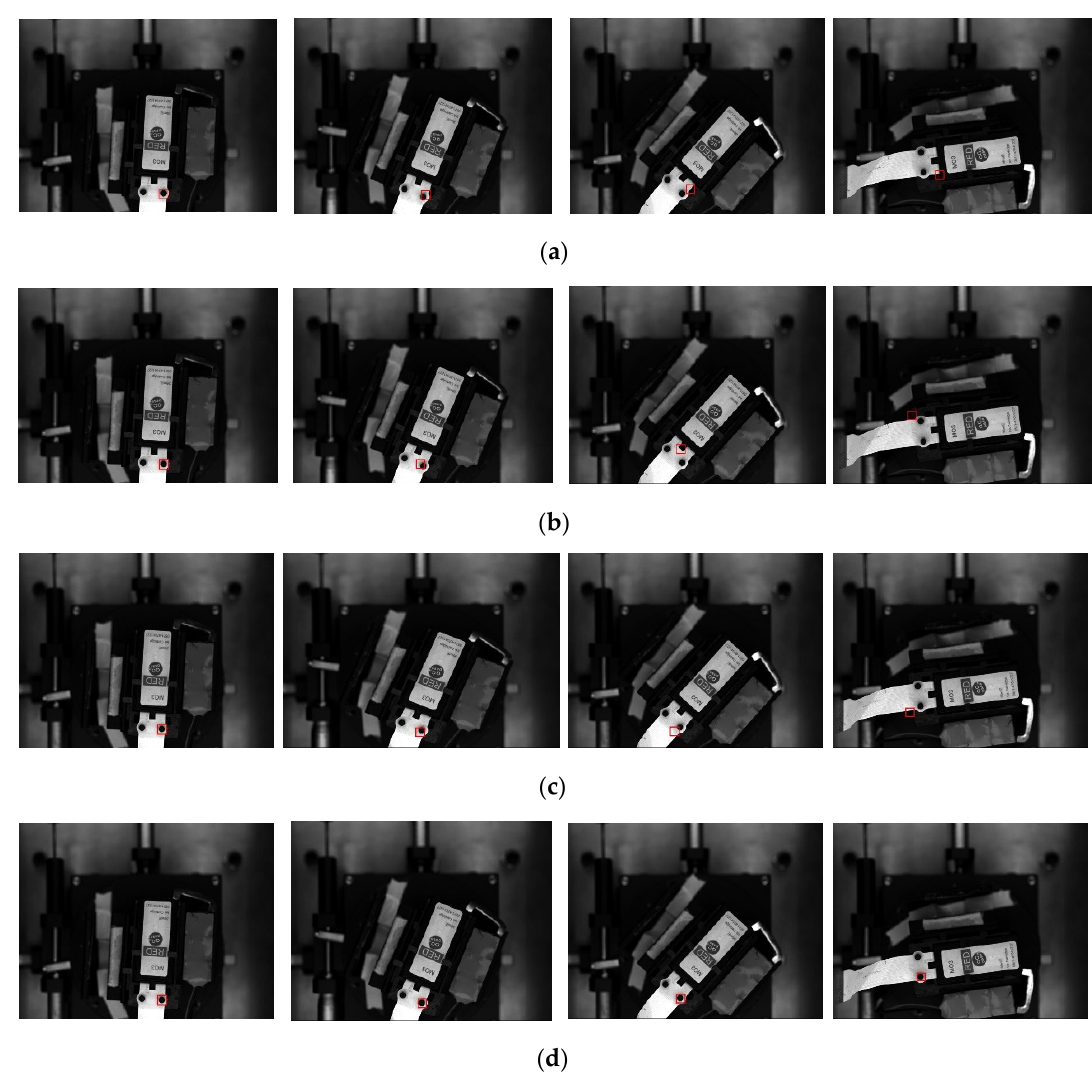
Figure 23. Comparing the trackers’ performance for micro-object fast motion case: ( a ) MOSSE tracker starts to fail at these frames; ( b ) improved KCF tracker starts to fail at these frames; ( c ) KCF tracker starts to fail at these frames; ( d ) K2CF tracker is successful at these frames. Table 1. Average precision and frame fps of 4 trackers.